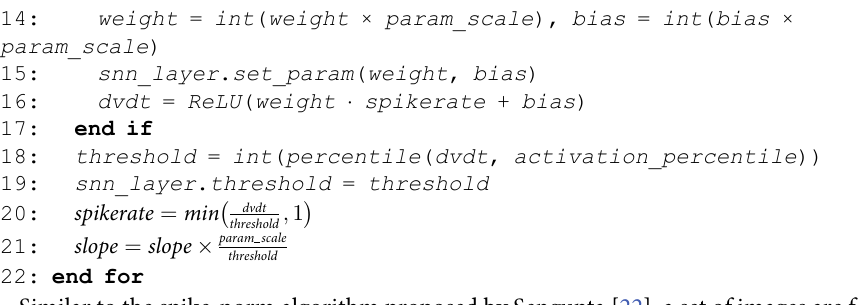
Algorithm 1 requires a batch of input images to tune the spiking threshold, and they are represented as an N × H × W × C matrix with floating-point elements ranging between